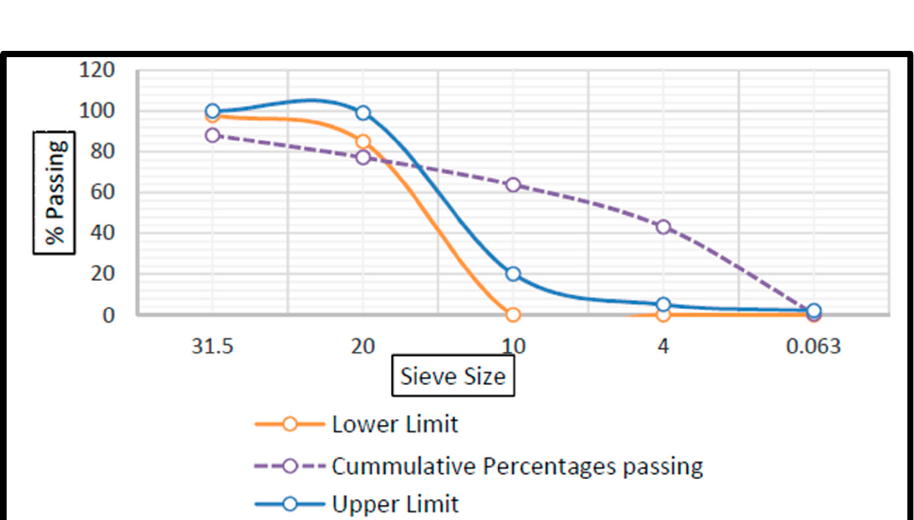
Figure 2. Particle size distribution of TBM muck and PD 6682-1 gradation requirements for concrete aggregates.